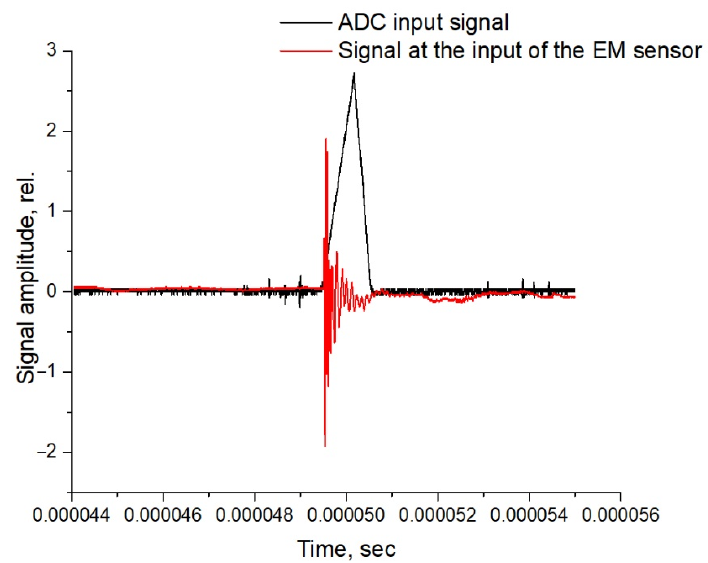
Figure 7. The signal of one PD received by each ultrasonic receiver of the microphone array. The PD signal recorded by the EM sensor is shown in Figure 8.